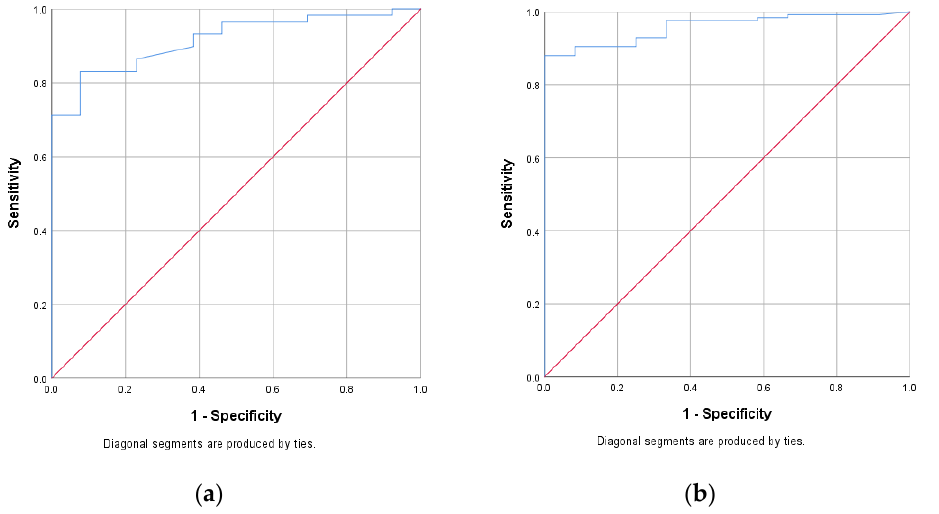
Figure 1. ROC (receiver operating characteristic) curve corresponding to the proposed activity score in ( a ) Crohn’s disease and ( b ) ulcerative colitis.